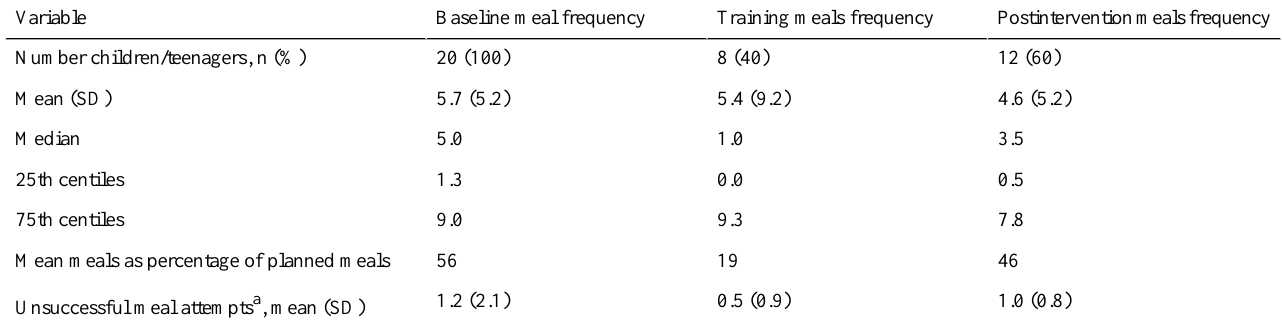
Table 3. Summary statistics for the use of Mandolean device at baseline (all participants), intervention phase (intervention only), and postintervention (all